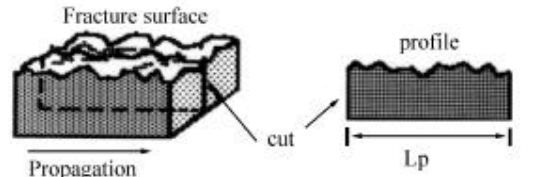
Figure 3. A fracture surface and its corresponding cutting